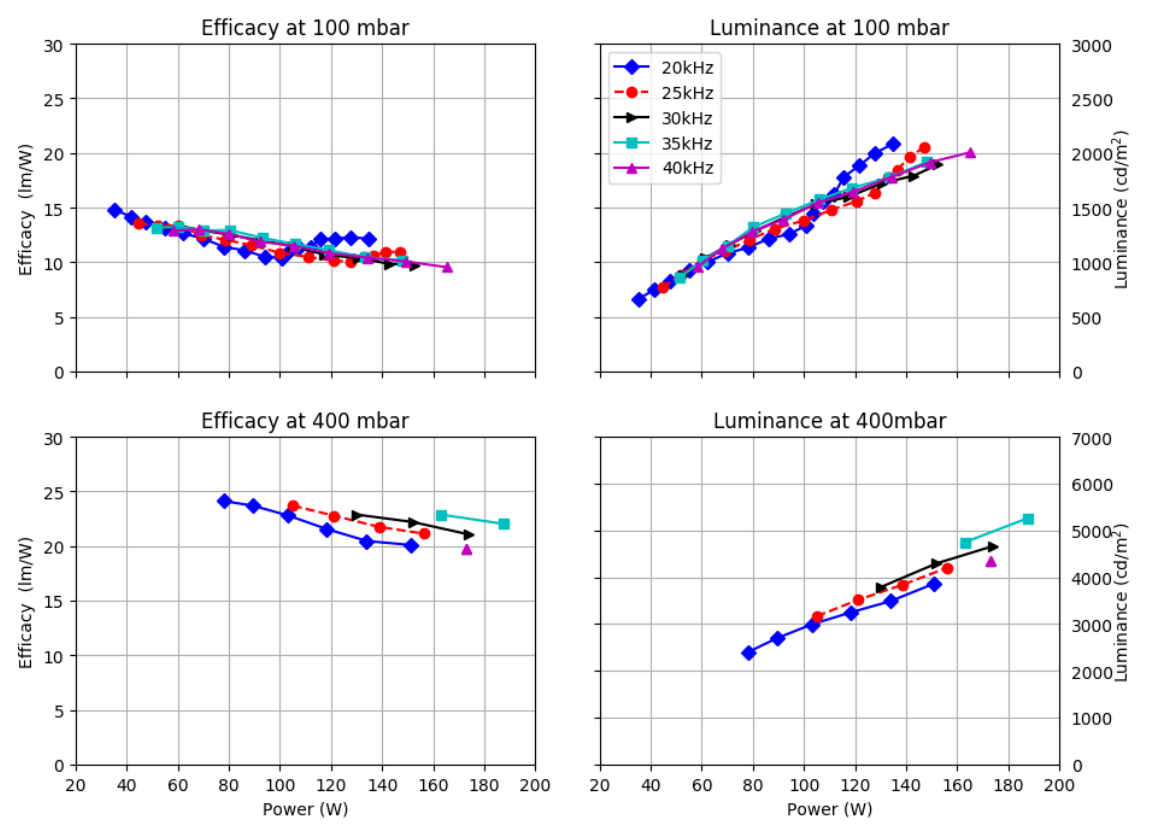
Figure 9. Luminance and efficacy as a function of power, frequencies (20–40 kHz) and 2 pressures (100–400 mbar) in plane-to-plane geometry and pulse power supply. Duty cycle 1%. 10 replicates, standard deviation 10%.